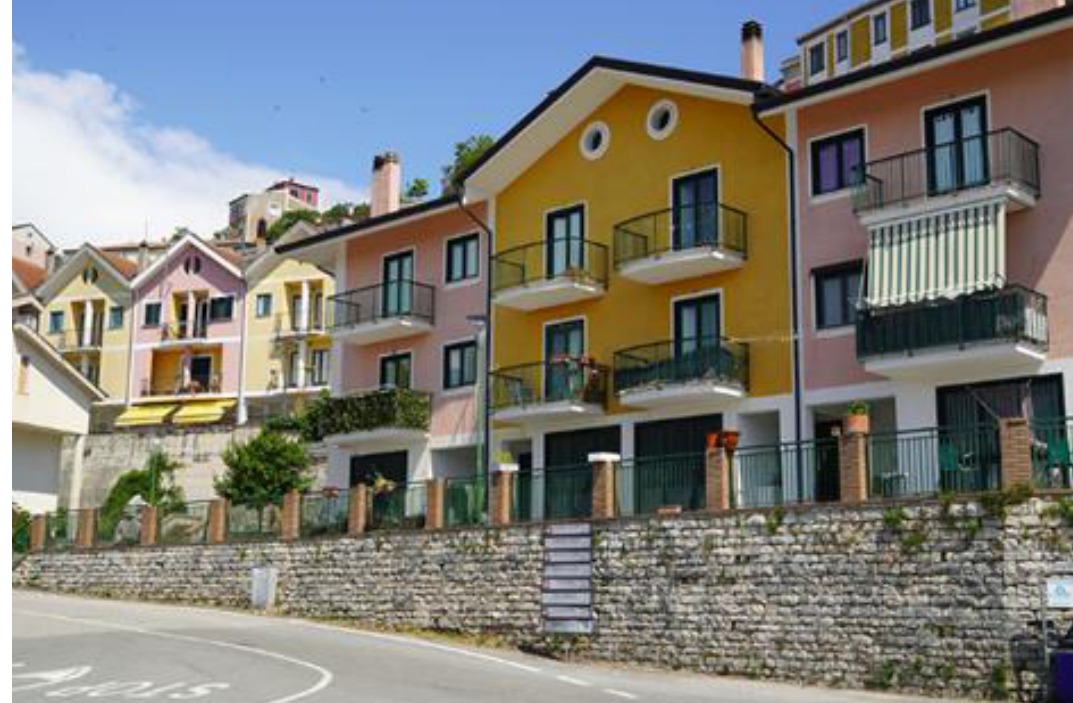
Figure 6. Castelnuovo di Conza: detail of the new village completely rebuilt after the1980 earthquake (photos by [35,36]).